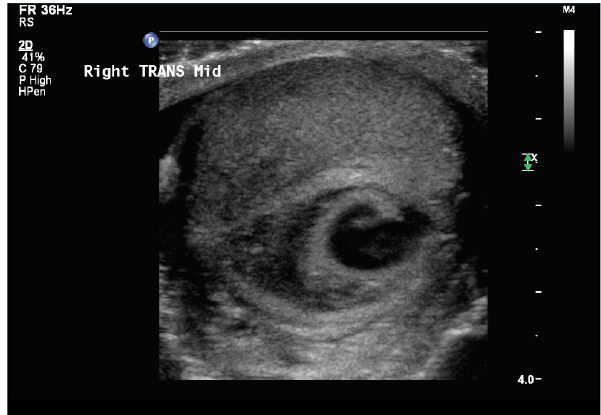
Figure 1. Scrotal ultrasound of the right testicle in transverse revealing a hypoechogenic lesion within the central testicle with an anechoic central core.